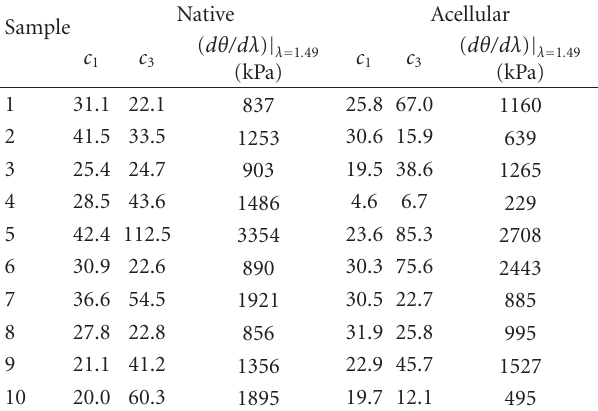
Table 5: Extended data for Protocol B.